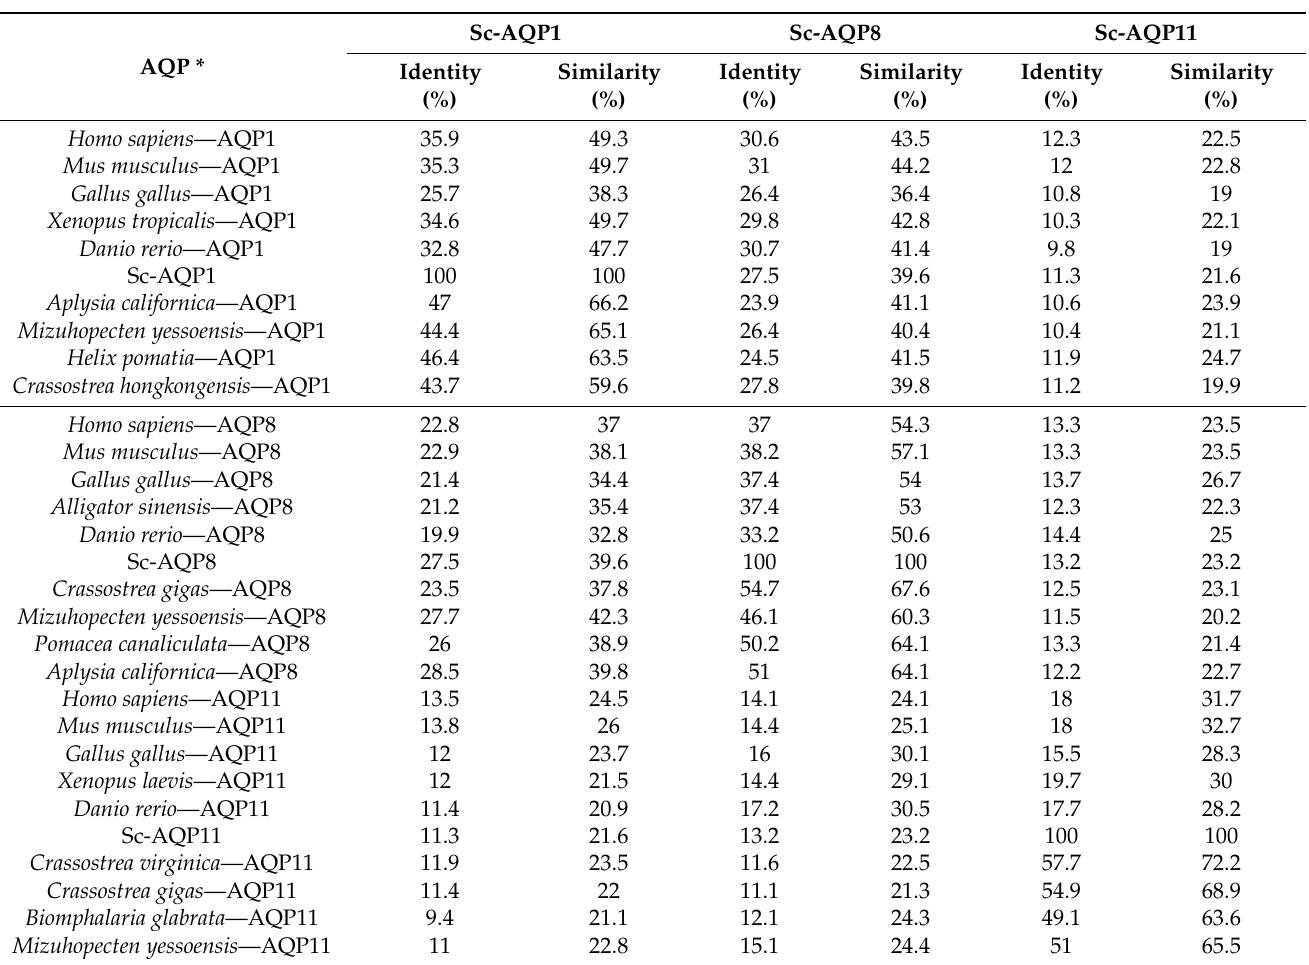
Table 3. Amino acid identity and similarity of Sc -AQP1, Sc -AQP8, and Sc -AQP11 putative peptides as compared with other AQP1, AQP8, and AQP11